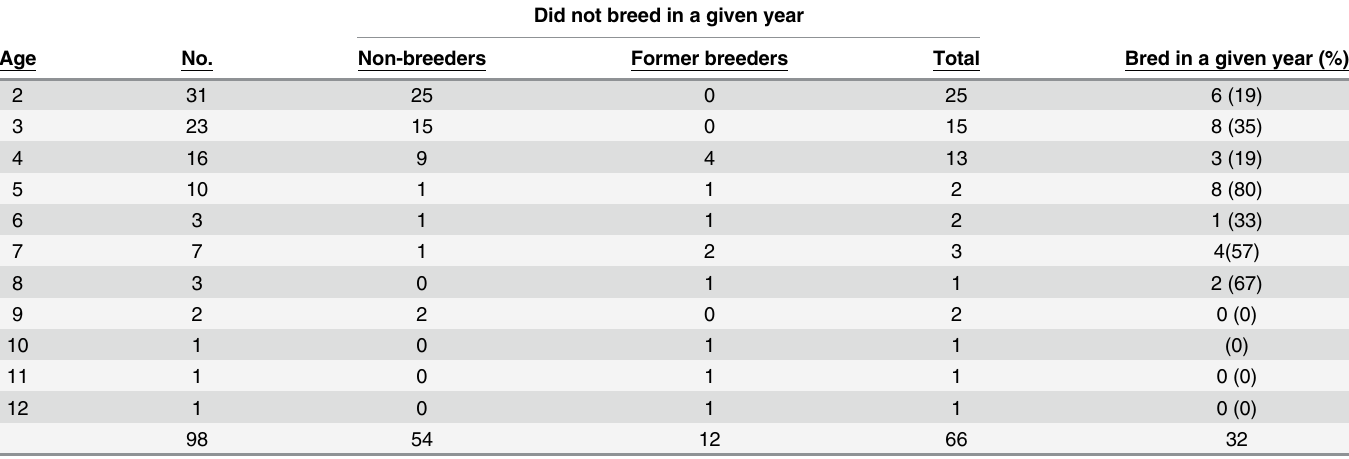
Table 3. Female wolves in the Superior National Forest, 1972 – 2013, that bred or did not breed in a given year based on the Mech et al. [24] formula and/or our adjustments (8 wolves) a based on field studies. Fifteen wolves with ambiguous classification and no additional field data (Table 1) were excluded.